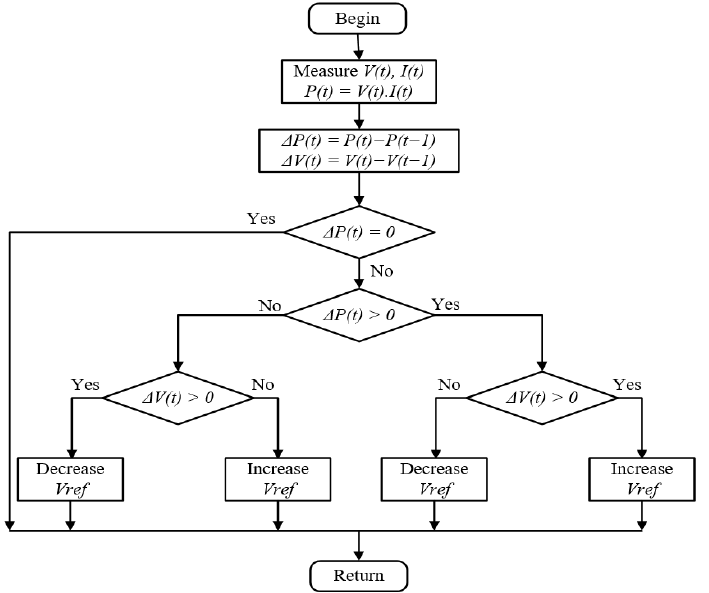
Figure 7. Flowchart of the P&O algorithm.